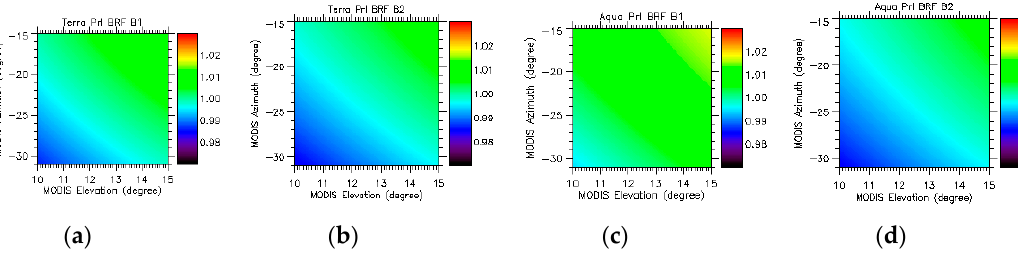
Figure 4. Terra MODIS ( a ) and ( b ) and Aqua MODIS ( c ) and ( d ) solar diffuser (SD) bi-directional reflectance factors (BRF) for bands 1 (0.65 µm) and 2 (0.86 µm).